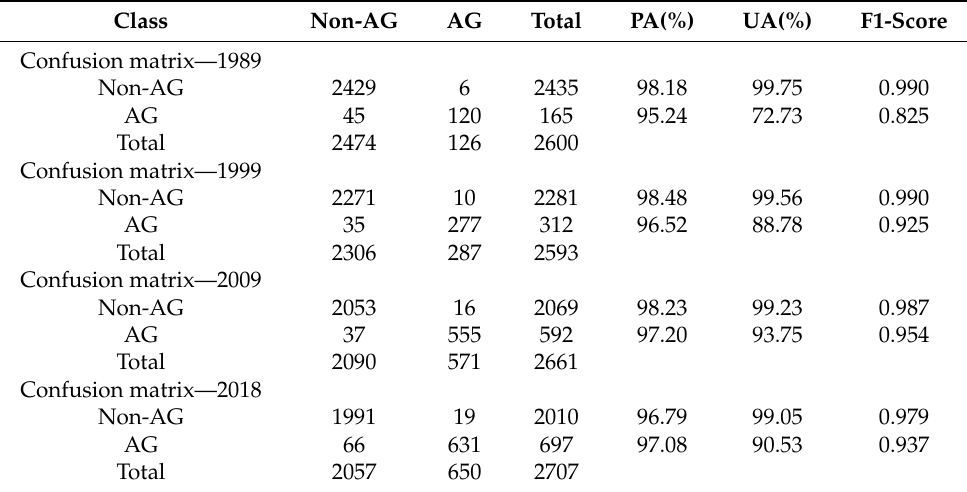
Table 4. Classification performance of AG in specific